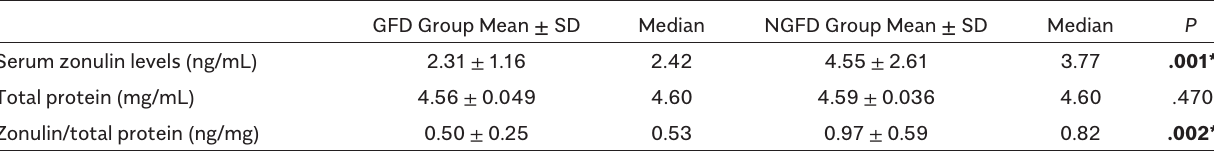
Table 3. Serum zonulin, Total Protein Levels, and Zonulin/Total Protein Ratio of